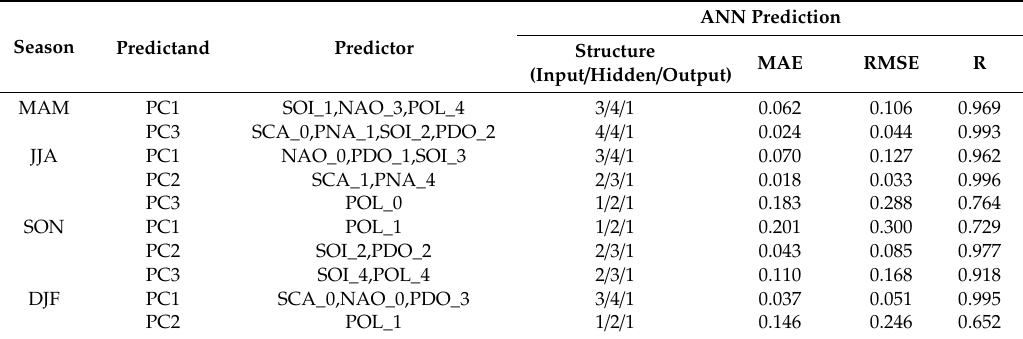
Table 4. Performance and structure of the predictive ANN